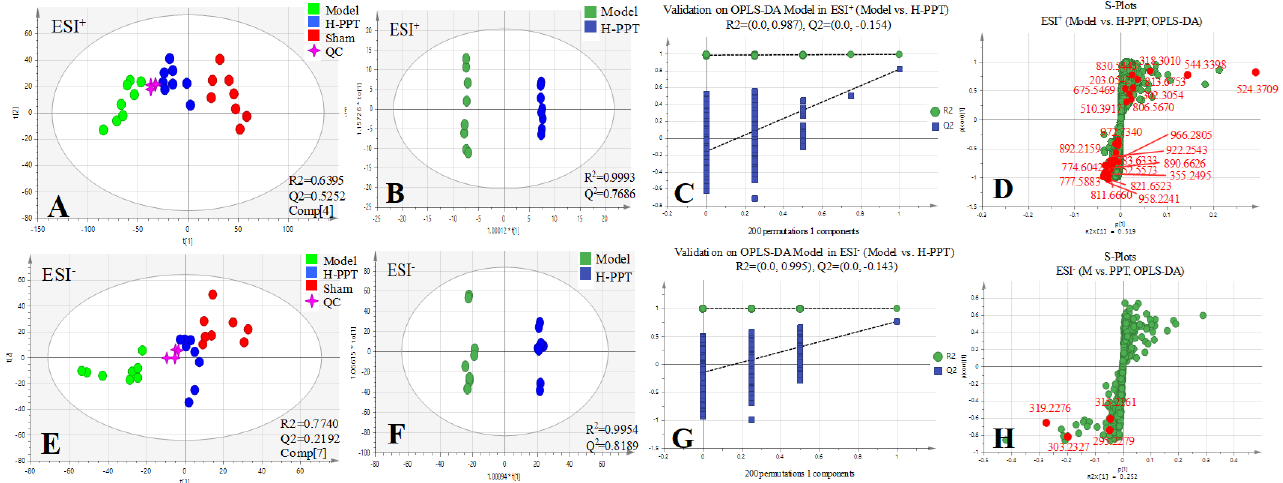
Figure 5. Multivariate statistical analysis resulting from rat serum. ( A , E ) PCA score plots of serum metabolic profiling of sham, model and H-PPT groups in positive and negative modes; ( B , F ) OPLS- DA score plots of model and H-PPT groups in positive and negative modes; ( C , G ) the permutations plots of the OPLS-DA models in positive and negative modes; ( D , H ) S-plots of serum metabolic profiling in positive and negative modes.